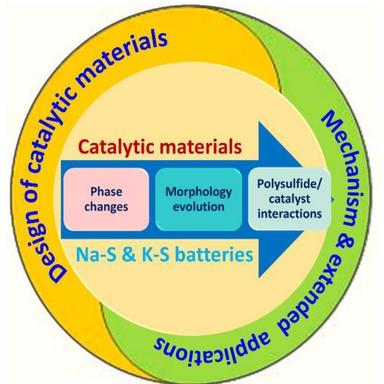
Schematic outlook on the design and development of catalytic materials NaeS and KeS batteries.